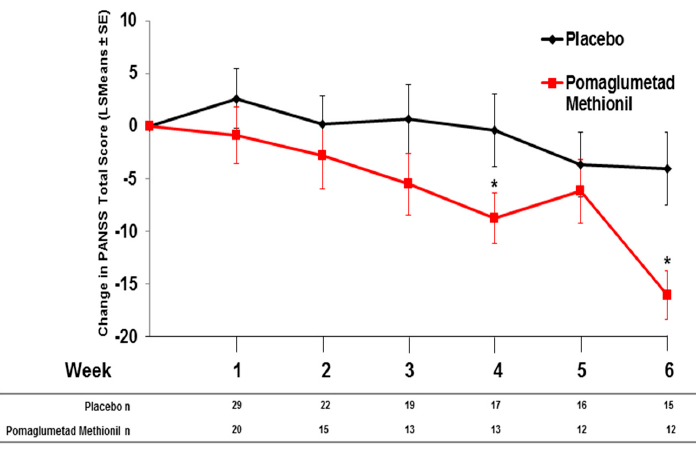
Figure 7. Cont. Figure 7.